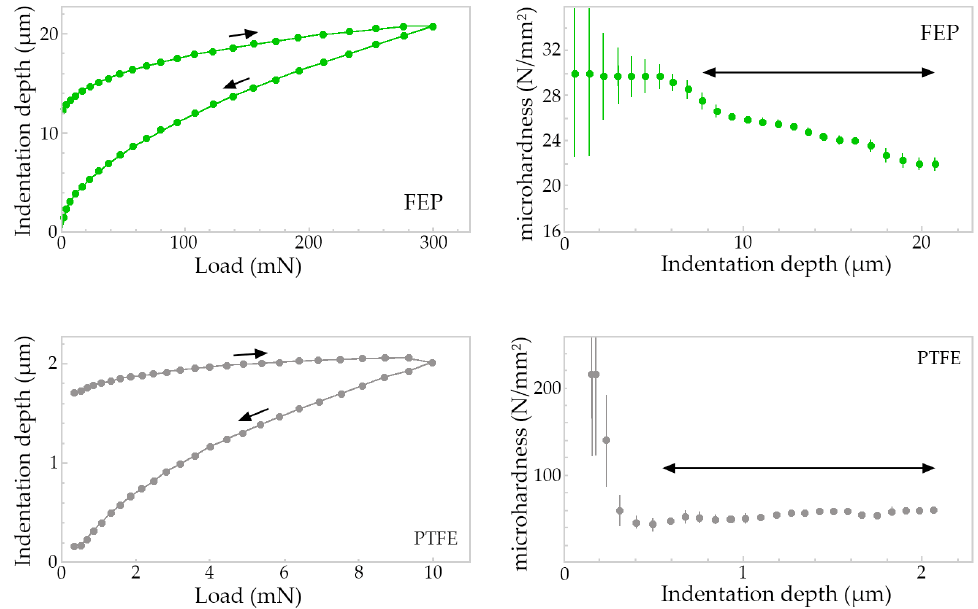
Figure 4. The load–unload curves (left) and microhardness (right) measured in FEP and PTFE